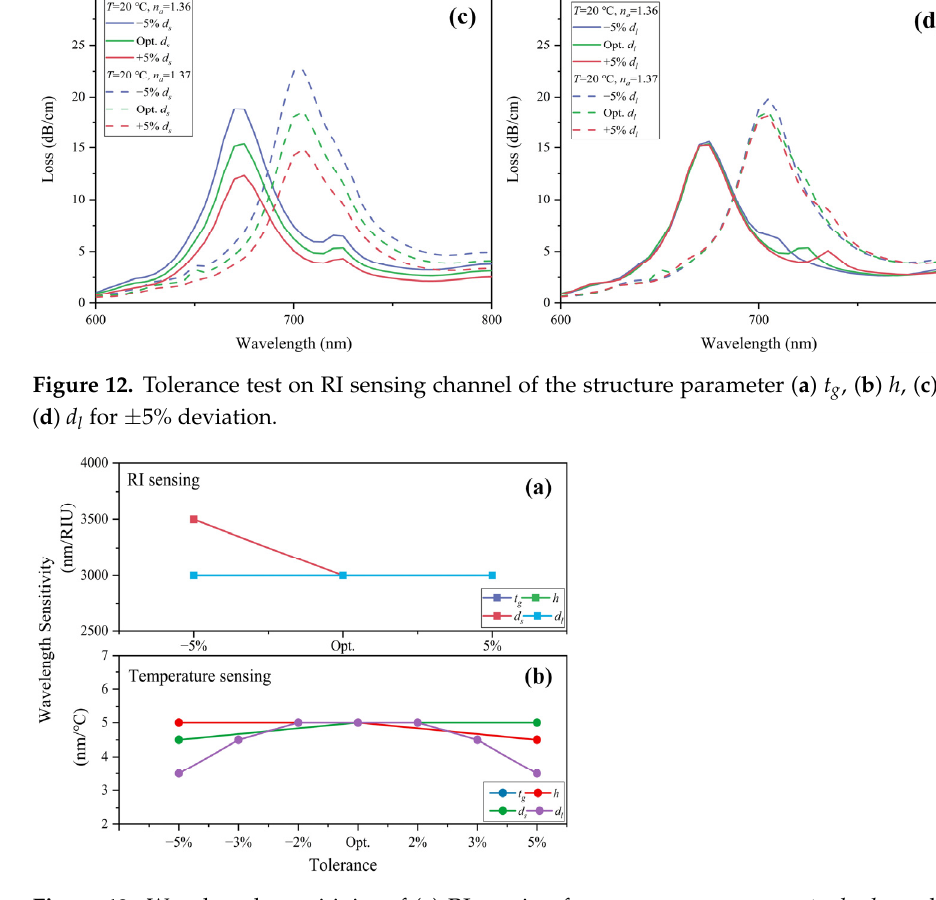
Figure 14. Tolerance test on temperature sensing channel of the structure parameter ( a ) t g , ( b ) h , ( c ) d s for ±5% deviation, and ( d ) d l for ±2%, ±3%, ±5% deviation. Manufacturing is an essential part of the proposed sensor to be practically applied. In Figure 15, the manufacturing process of the reported flat PCF plasmonic sensor is illus- trated. We suggest the following ways by which our sensor can be implemented. The stack-and-draw method [37] can be adopted to fabricate the PCF structure. Silica tubes with good geometric dimensions and optical surfaces are selected. Capillaries of different diameters are drawn through a drawing tower after rigorous cleaning. The drawn capil- laries are tightly packed according to the designed structure. The preform stacking con- figuration of the proposed sensor is shown in Figure 15. Solid rods, thick-wall, and thin- wall rods are used to form cavities of different sizes. The stacked rods are drawn in a jacket through a high-temperature furnace that is heated to 1850–1900 °C [38] to soften. The cane